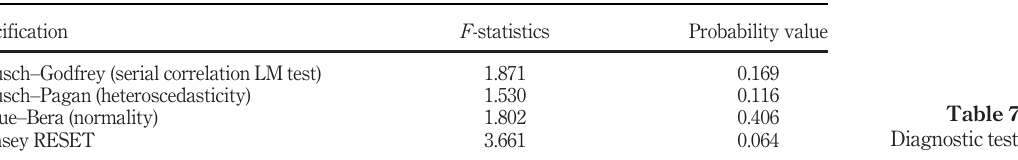
Table 7. Diagnostic